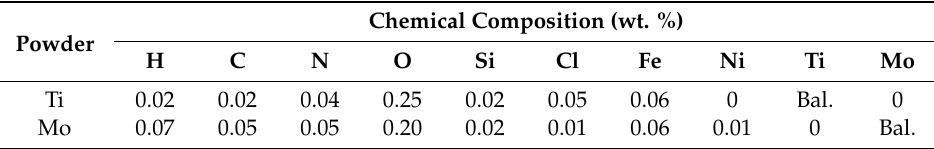
Table 1. Chemical composition of titanium and molybdenum powders (wt. %). Chemical Composition (wt. Powder